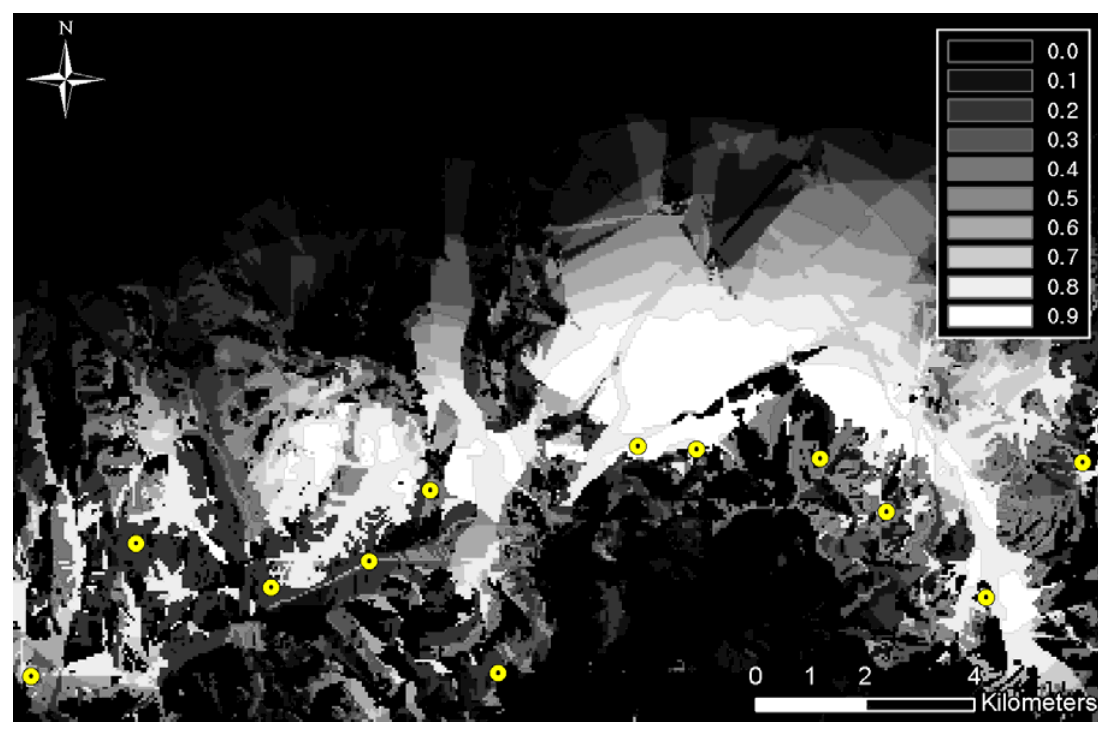
Figure 9. Final detection probability